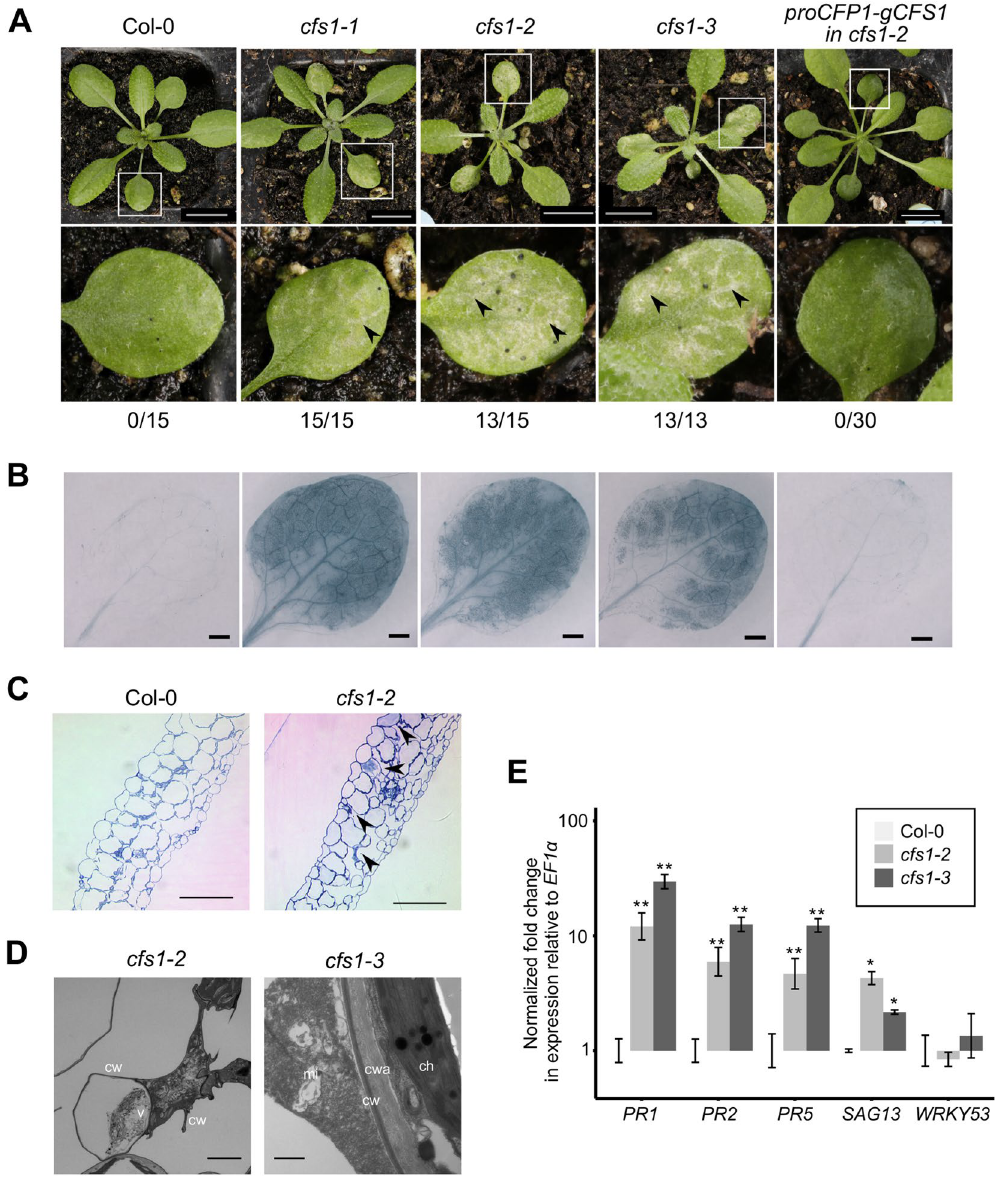
Figure 2. cfs1 mutants display an autoimmune phenotype. ( A ) Three-week old Col-0, cfs1-1 , cfs1-2 , cfs1-3 and cfs1-2 expressing the CFS1 genomic fragment driven by its native promoter ( pCFS1-gCFS1 in cfs1-2 ). Squares indicate the digitally magnified region below. Arrowheads indicate lesions. Scale bars: 1 cm. The values below each row represent the number of plants displaying lesions and total number of plants observed from one representative experiment, respectively. ( B ) Trypan blue staining of the first and second leaf of a three-week old plant. The genotype for each image is indicated in the respective panel A. Scale bars: 1 mm. ( C ) Semi-thin cross-sections of Col-0 and cfs1-2 first leaf of a three-week old plant. Samples were stained with toluidine blue. Arrowheads indicate dead cells. Scale bars: 100 µ m. ( D ) Representative TEM pictures of cells in leaf 1 or 2 of three-week old cfs1 plants. In cfs1-2 , dead cells contain the unprocessed cell corpse, a characteristic of necrotic cell death (Scale bar is 5 µ m). In cfs1-3 , cell wall appositions between living and the neighboring dead cells, degraded mitochondria and chloroplast are shown (Scale bar is 0.1 µ M). (c: cytosol, ch: chloroplast, cw: cell wall, cwa: cell wall appositions, mi: mitochondria, v- vacuole). Dead cells could be readily observed in all cfs1 alleles but never in any of the Col-0 samples. ( E) Upregulation of PR1 , PR2 , PR5 , SAG13 and WRKY53 expression in cfs1-2 and cfs1-3 compared with Col-0. Values are plotted in exponential scale (log 10 ). Error bars represent the standard error of three biological replicates with two technical replicates. Double asterisks indicate statistical significance at p ≤ 0 .01, and an asterisk indicates statistical significant at p ≤ 0.05 (ANOVA test, followed by Tukey’s Honest Significance